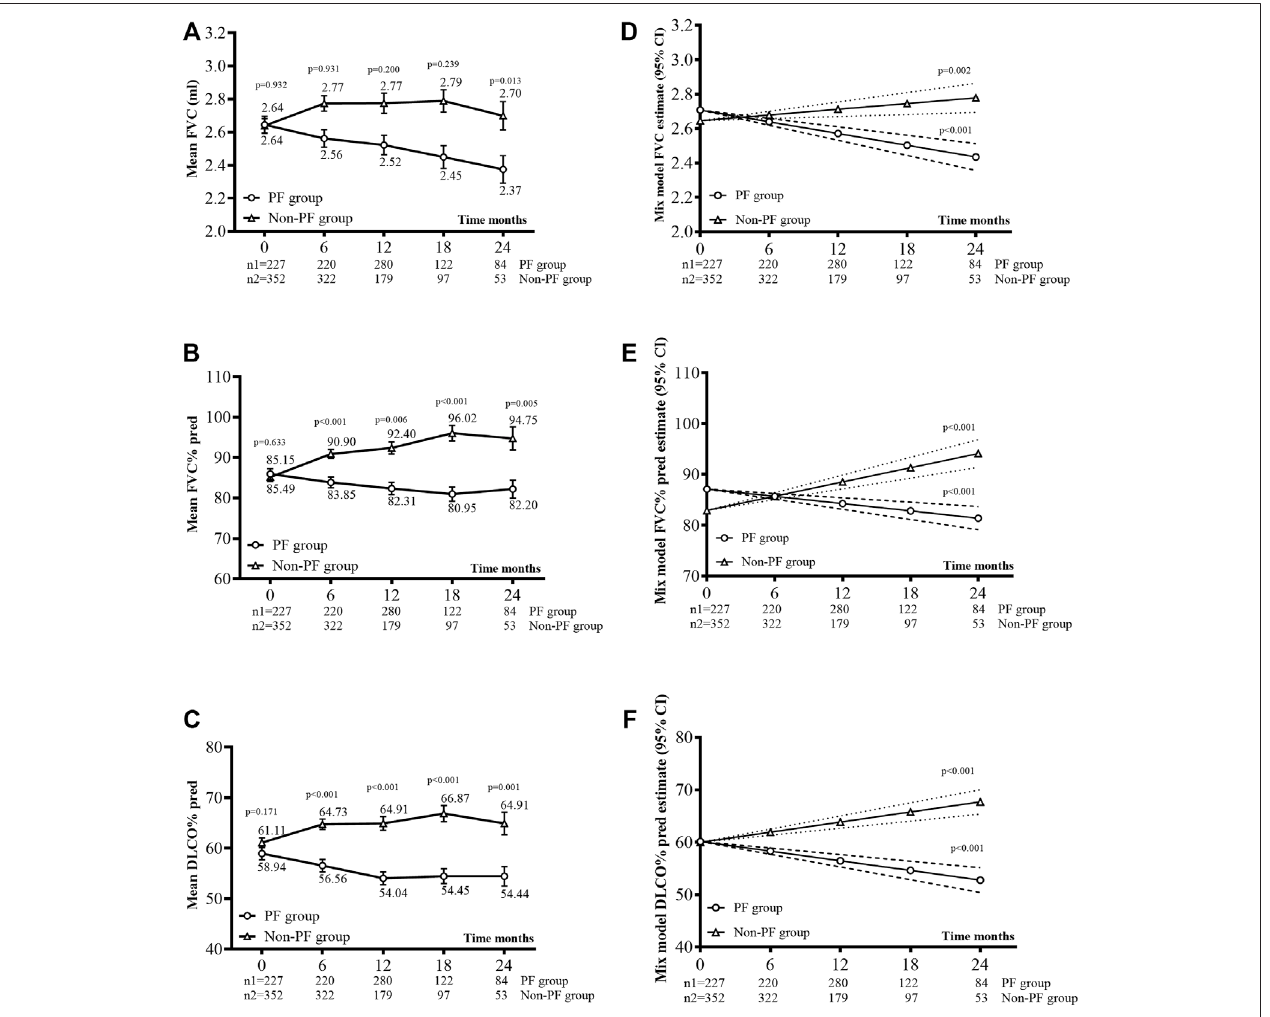
FIGURE2| Lungfunctionchanges. (A) , (B) ,and (C) MeanFVCml(±SE),meanFVC%predicted(±SE),andmeanDLCO%predicted(±SE)duringobservation. (D) , (E) , and (F) Disease behavior (FVC, FVC% pred, and DLCO% pred) over time was analyzed using a linear mixed model for each group, with a random effect for the intercept and slope. The covariance for the repeated measures was left AR (autoregressive)1: heterogeneous, as this yielded the best fi t.